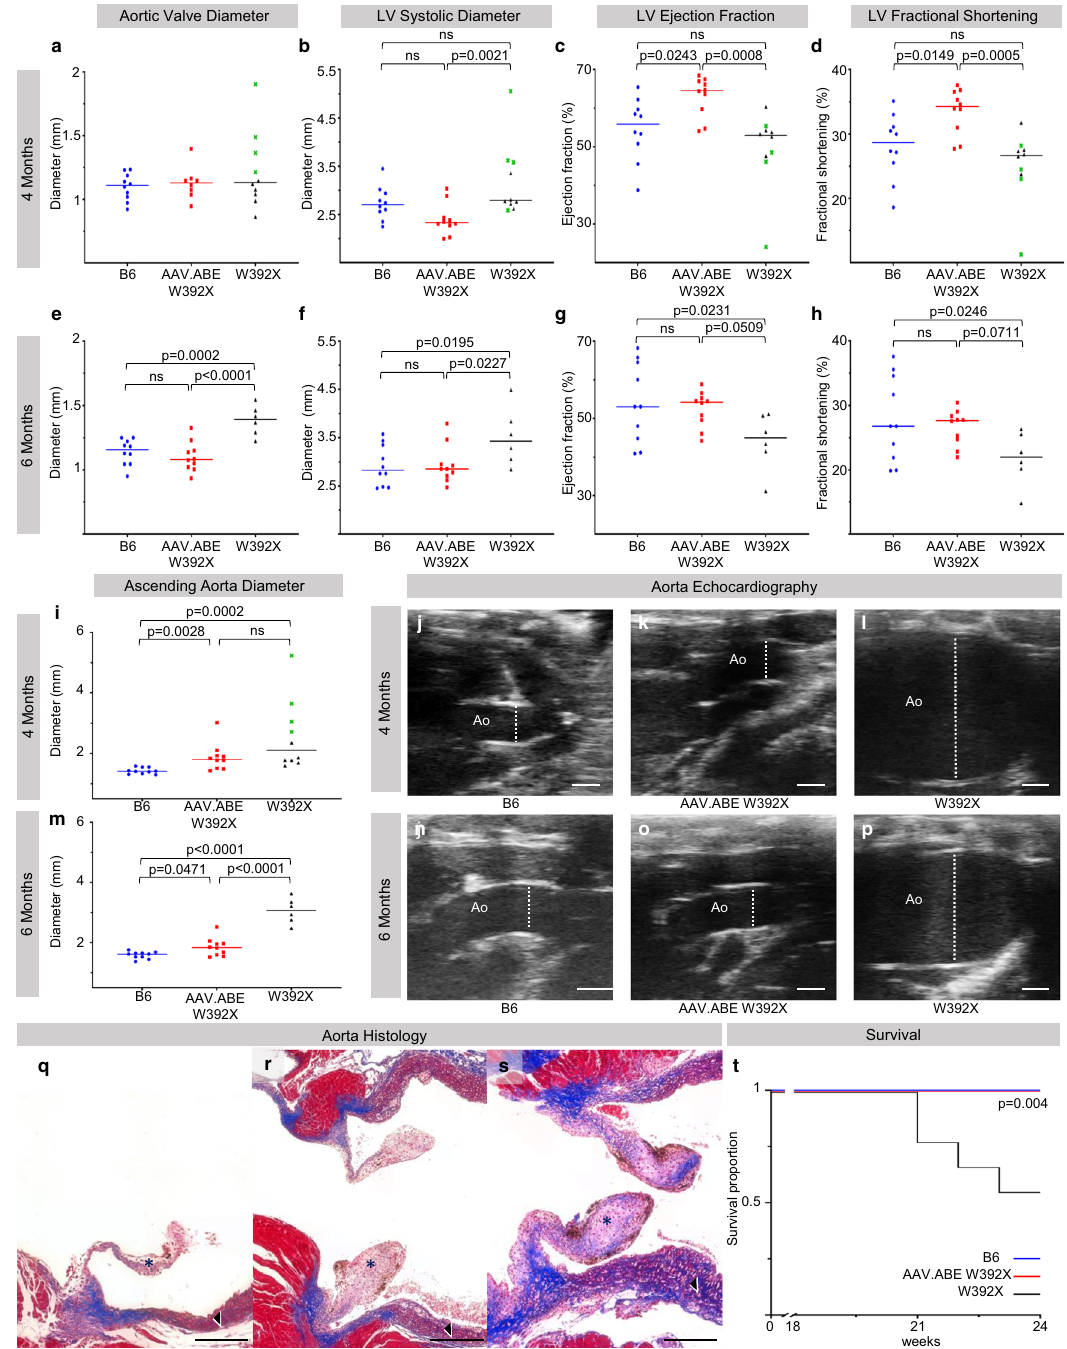
Fig. 4 In utero base editing improves cardiac function and survival in Idua-W392X mice. a – d Echocardiographic parameters were measured in 4-month- old B6 ( N = 10), Idua- W392X mice prenatally injected with AAV.ABE.Idua ( N = 10, except 4-month aortic valve diameter, N = 8), and uninjected Idua- W392X mice ( N = 10). Mice that died prior to 6 months of age are denoted with a green X. e – h Echocardiographic parameters were measured in 6-month- old B6 ( N = 10), prenatally injected mice ( N = 10), and surviving uninjected mice ( N = 6). i – l Ascending aorta diameter and representative ultrasounds from 4-month-old B6 ( N = 10), prenatally injected mice ( N = 10), and uninjected mice ( N = 10). Mice that died prior to 6 months of age are denoted with a green X. Scale bar = 1 mm. m – p Ascending aorta diameter and representative ascending aorta ultrasounds from 6-month-old B6 ( N = 10), prenatally injected mice ( N = 10), and surviving uninjected mice ( N = 6). Scale bar = 1 mm. q – s Representative Masson ’ s trichrome stain highlighting collagen deposition in aortic outlets including aortic valve (*), and ascending aorta (black and white arrow) in 6-month-old B6, prenatally injected mice, and uninjected mice. Red stains muscle, pink stains cytoplasm, black stains nuclei, and blue stains collagen. Images constructed with 40x tile stitch. Scale bar = 200 µ m. Staining was repeated in fi ve biological replicates per sample. t Six-month survival analysis comparing B6 ( N = 10), prenatally injected mice ( N = 10), and uninjected mice ( N = 10). Wilcoxon test for multiple comparisons used to assess 4 month ascending aorta diameter; Mantel – Cox method used to assess survival; Student ’ s t -test used for all other comparisons; α = 0.05. All tests two-sided. LV left ventricle, Ao aorta. AAV.ABE indicates AAV.ABE.Idua. Source data are provided as a Source Data fi